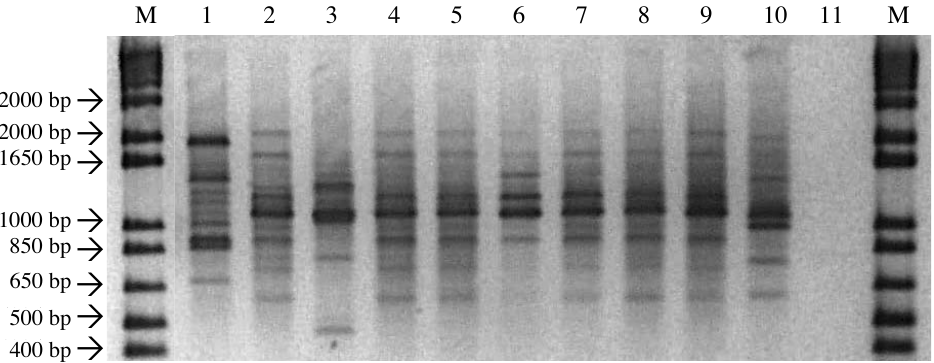
Fig. 1. MSP-PCR of Ralstonia solanacearum with primer CsM13. M, DNA ladder 1Kb plus (Invitrogen); Biovar 1 isolates - Lanes 1 to 10: 1, NCPPB 1029; 2, CPBF 674; 3, K60; 4, CPBF 1189; 5, CPBF 1192; 6, CPBF 1199; 7, CPBF 1200; 8, 1201; 9, CPBF 1211. Biovar 2 isolate- lane 10, CPBF 1212. Lane 11, negative